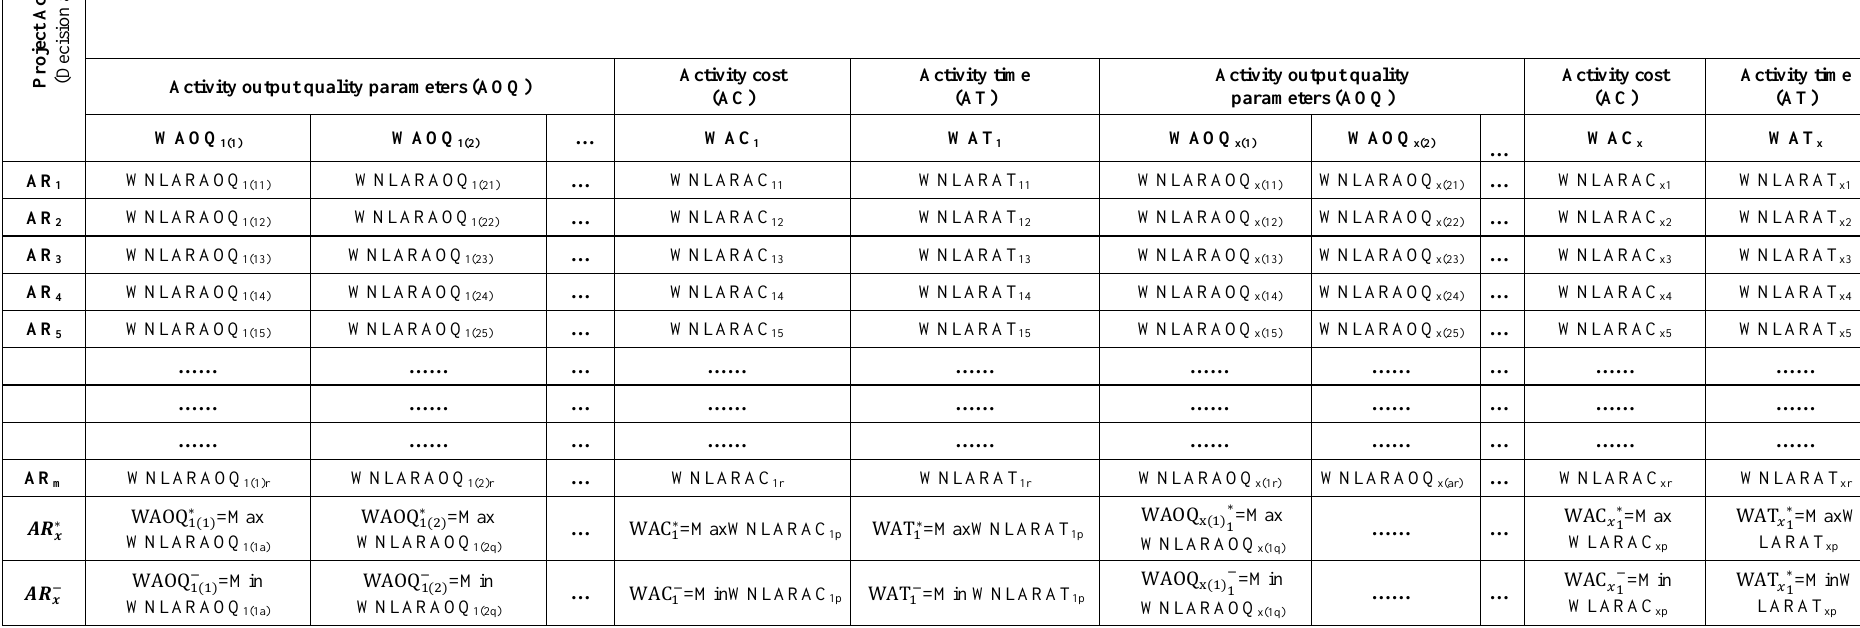
Table 2. Normalized and weighted TOPSIS mode activity risk prioritization